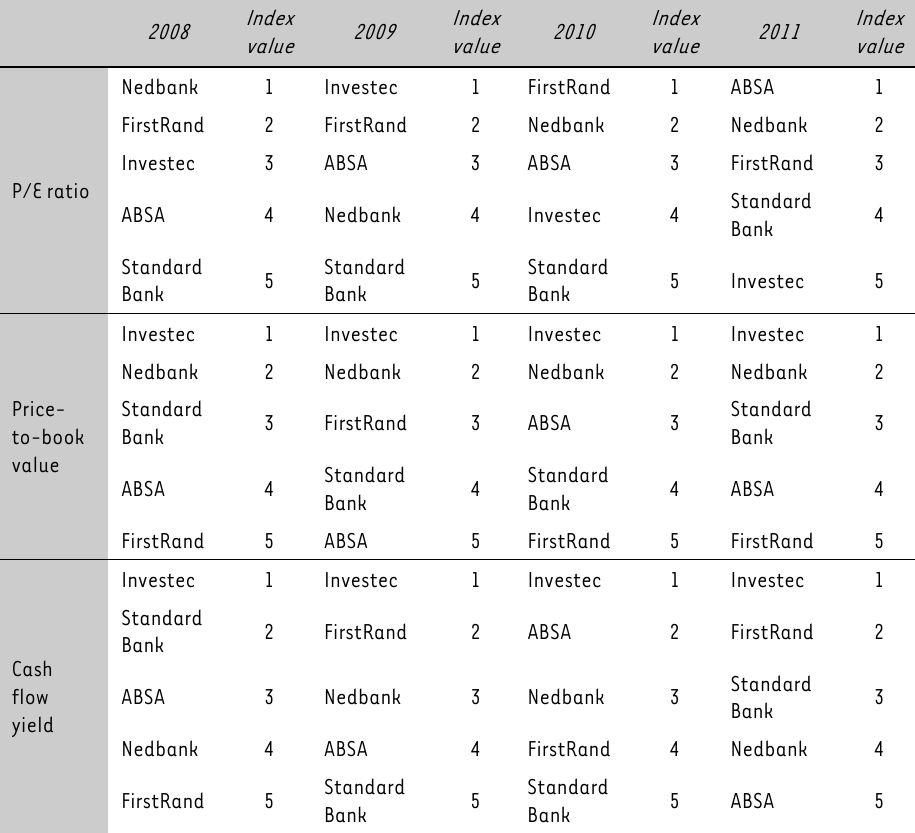
TABLE 9: A comparison of the financial measures (including final